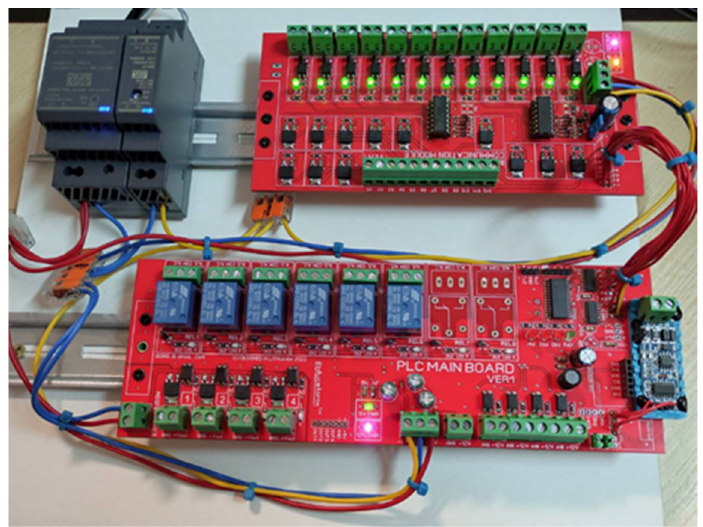
Figure 11. The general view of the main controller of the automatic control system.